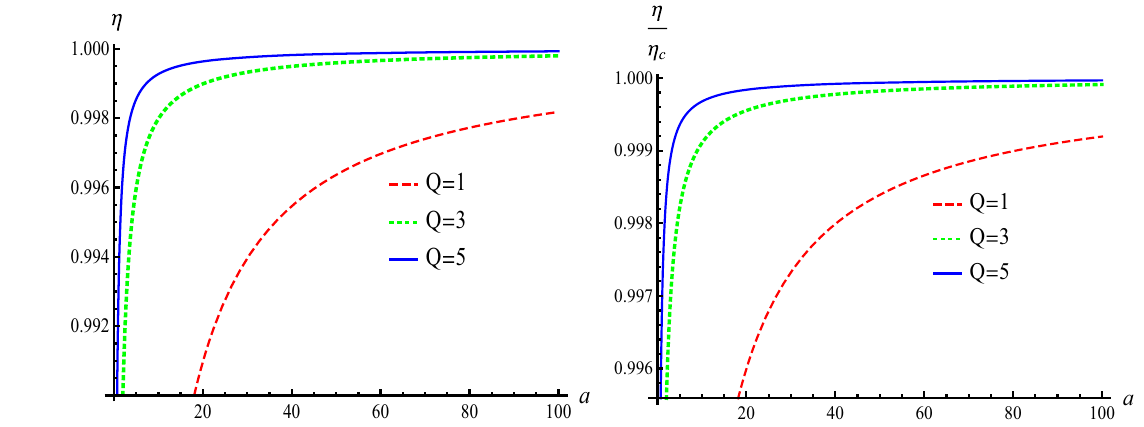
Fig. 14 The two figures above are plotted under the change of the normalization factor a at three different fixed electric charges Q , here we take α = 1